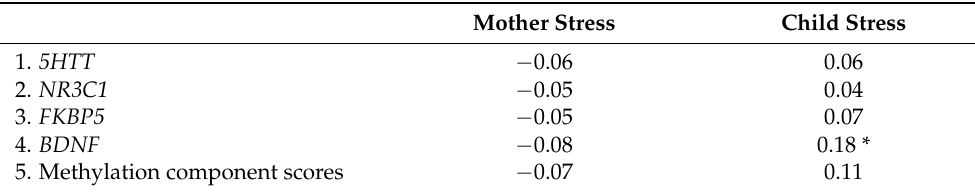
Table A2. Correlations between mothers’ and children’s recent stress and their respective methylation